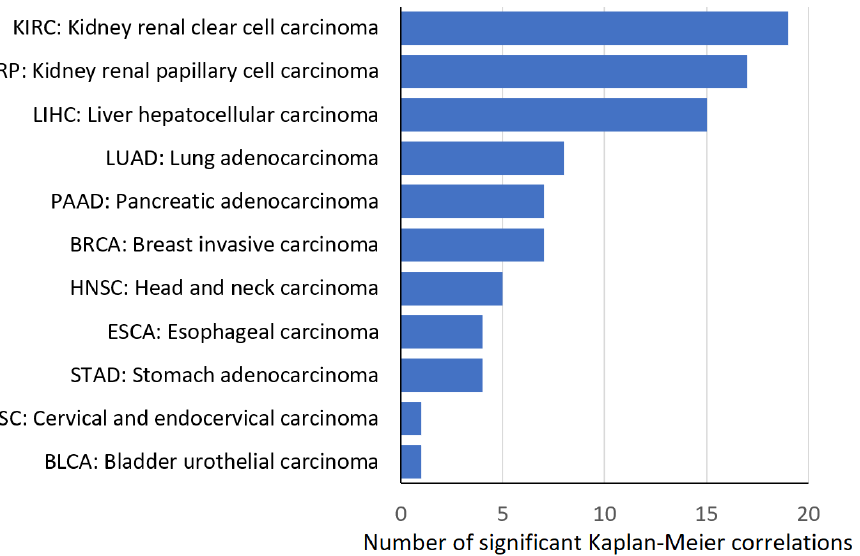
Figure 3. Number of significant Kaplan–Meier calculations for 11 tumor types.